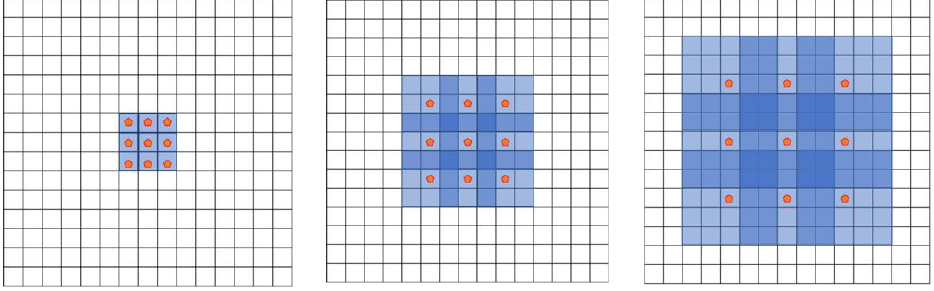
Figure 4. Atrous convolution [9] .